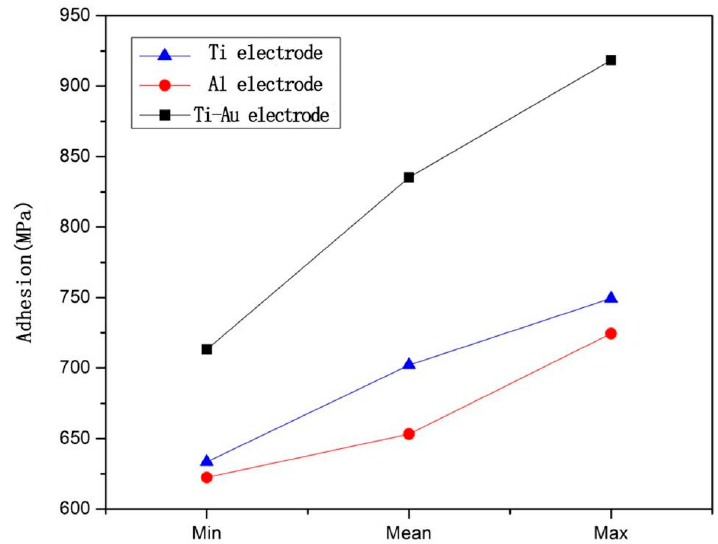
Figure 4. The adhesion between the Ti, Al, and Ti-Au electrodes and CdZnTe crystals.